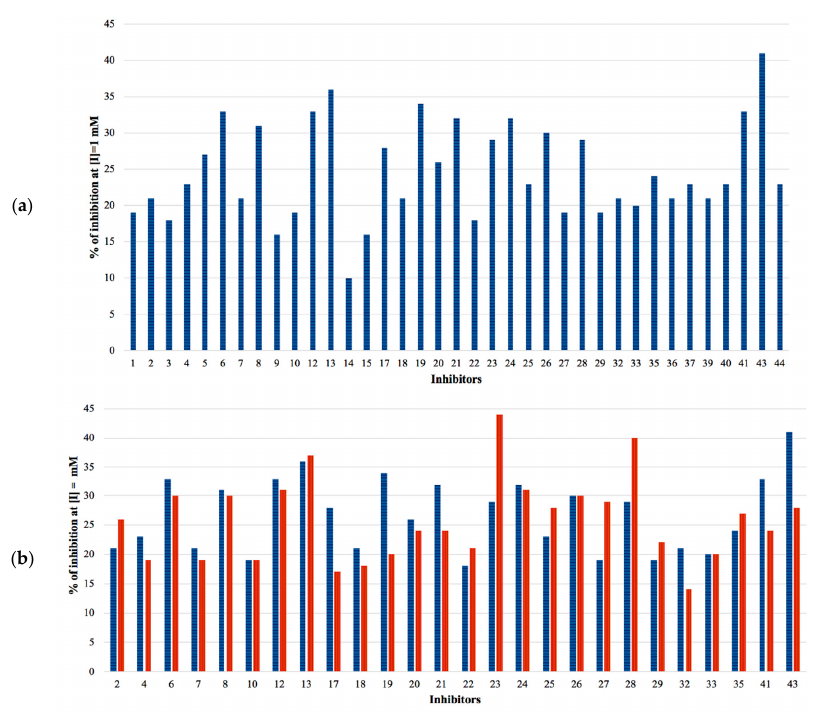
Figure 4. ( a ) Percentage inhibition against GES-5 at 1 mM inhibitor concentration. ( b ) Percentage inhibition at 1 mM inhibitor concentration against GES-5 (blue) and KPC-2 (red).